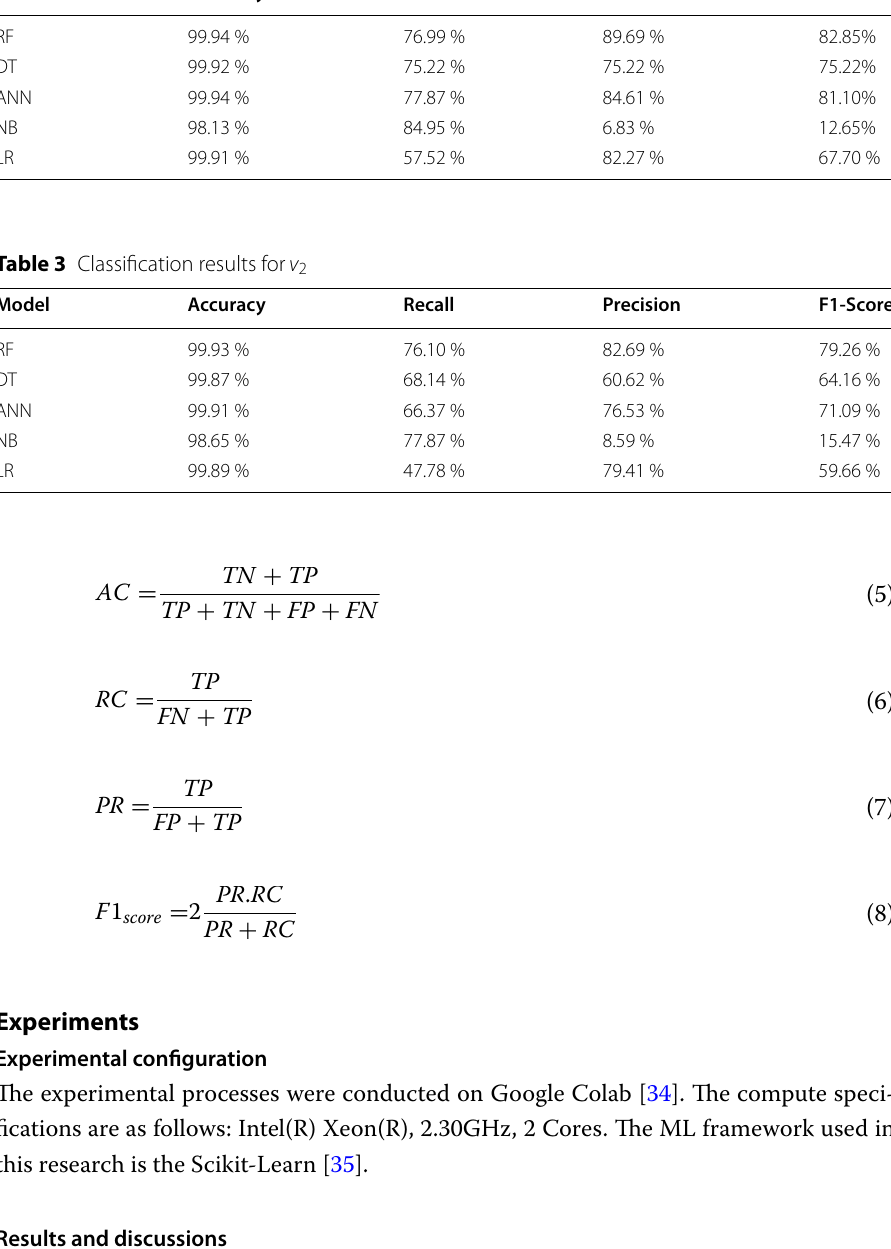
Table 2 Classification results for v 1 Model